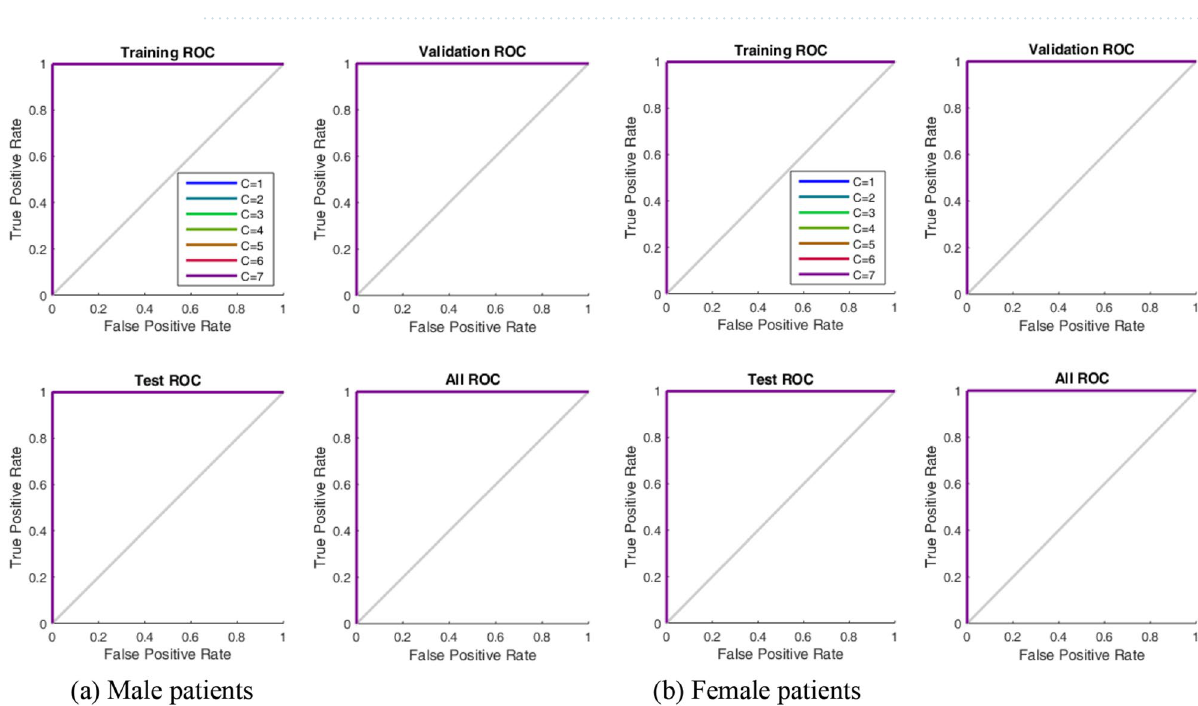
Figure 10. Receiver operation characteristics for k = 3, 5, 10, 15.